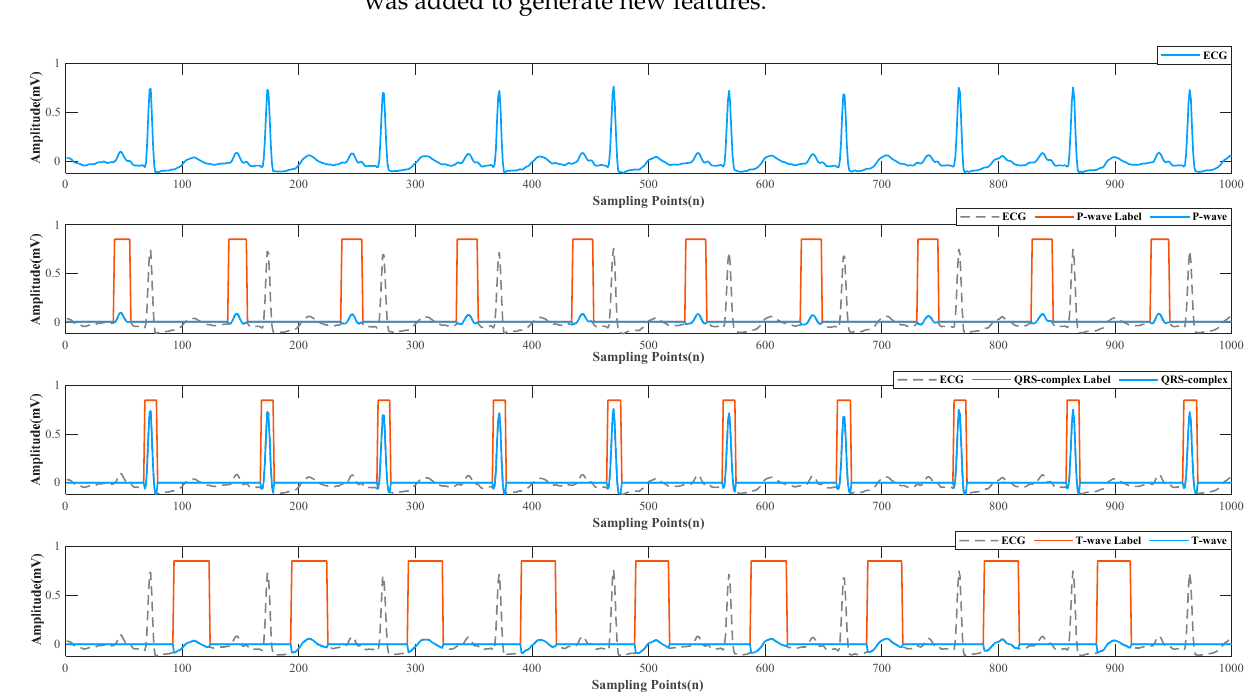
Figure 1. Raw ECG and P wave, QRS complex, T wave.